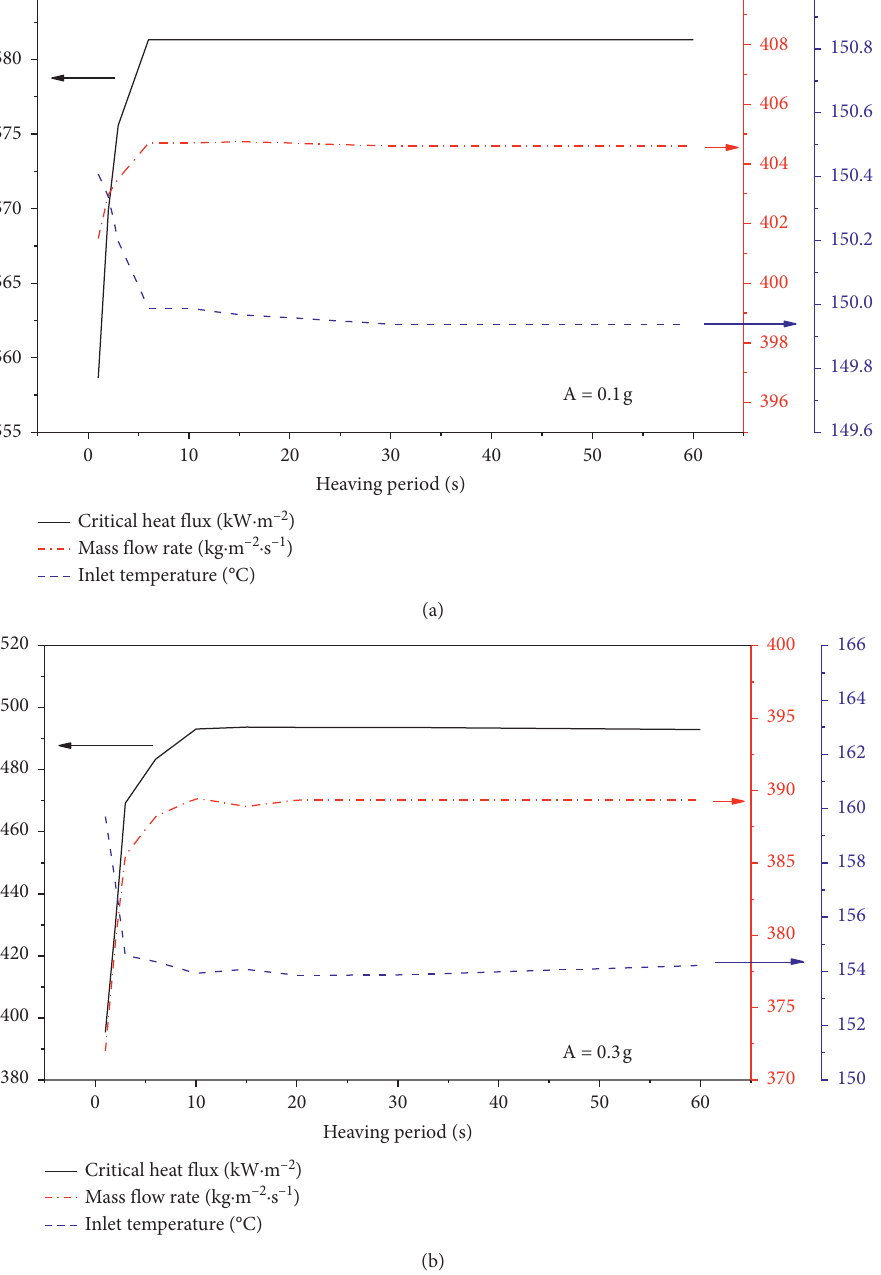
Figure 13: Influence of heaving period on CHF. (a) A � 0.1g. (b) A �